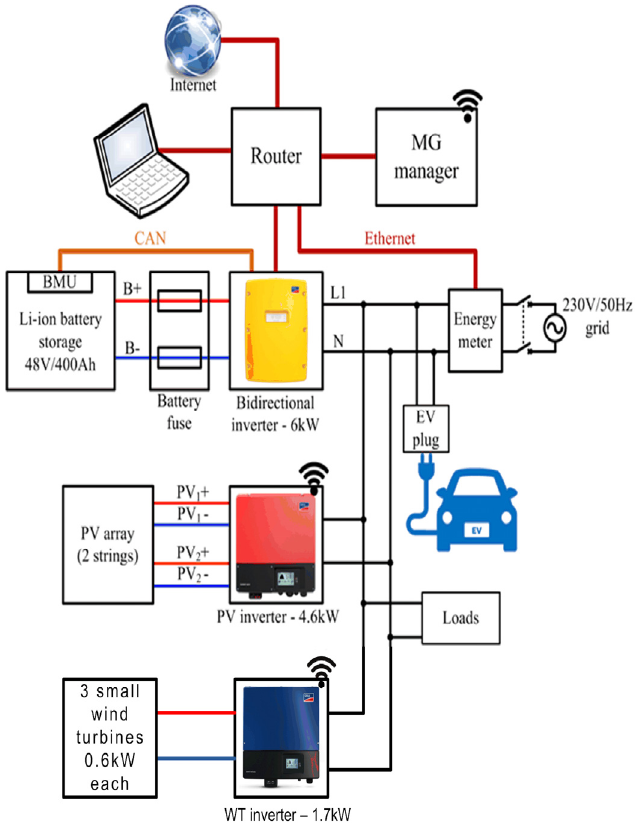
Figure 1. The structure of the Residential Charging Station with public access.